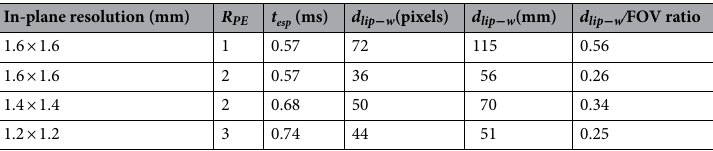
Table 1. Lipid-water shift for representative EPI parameters.